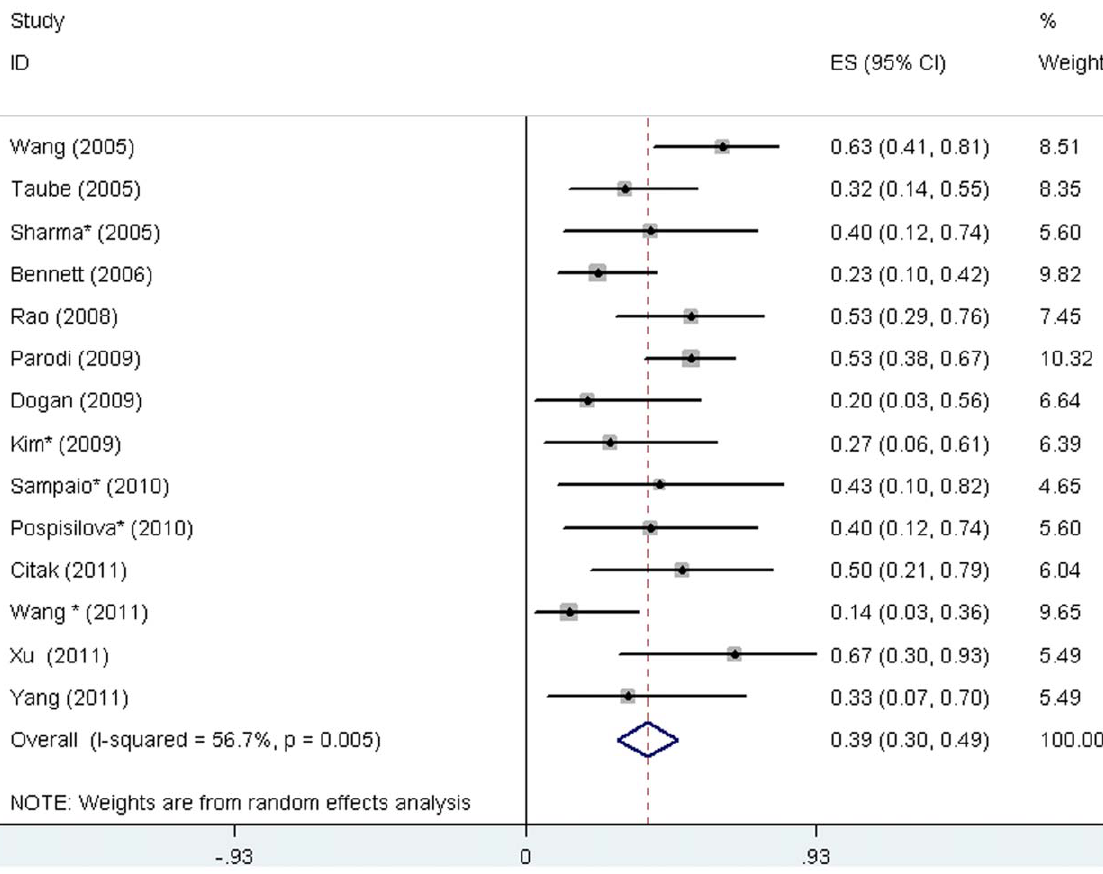
Figure 3. Complete response rate to rituximab in children with ITP. The diamond indicates the pooled complete response rate (39%). Test of heterogeneity: I 2 =56.7%, P=0.005.